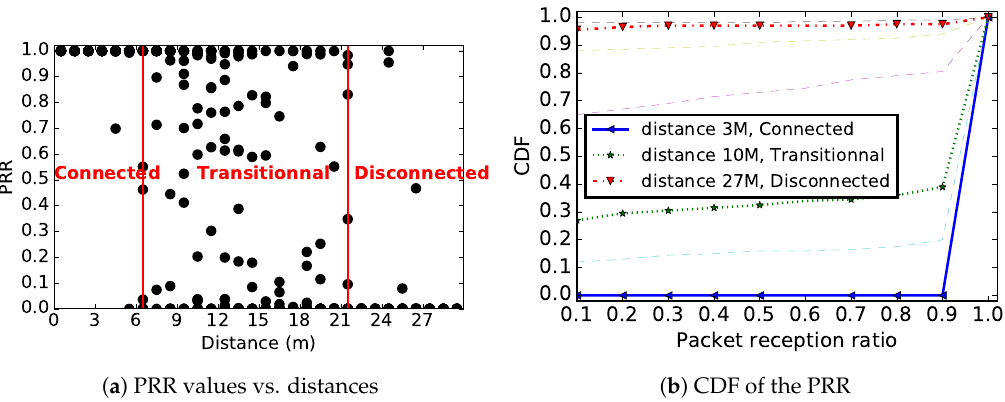
Figure 2. Theoretical packet reception ratio over a WSN link: non-coherent QPSK modulation, NRZ encoding, packet size 100 Bytes, α = 3.56, σ = 6.06, and P t = 0